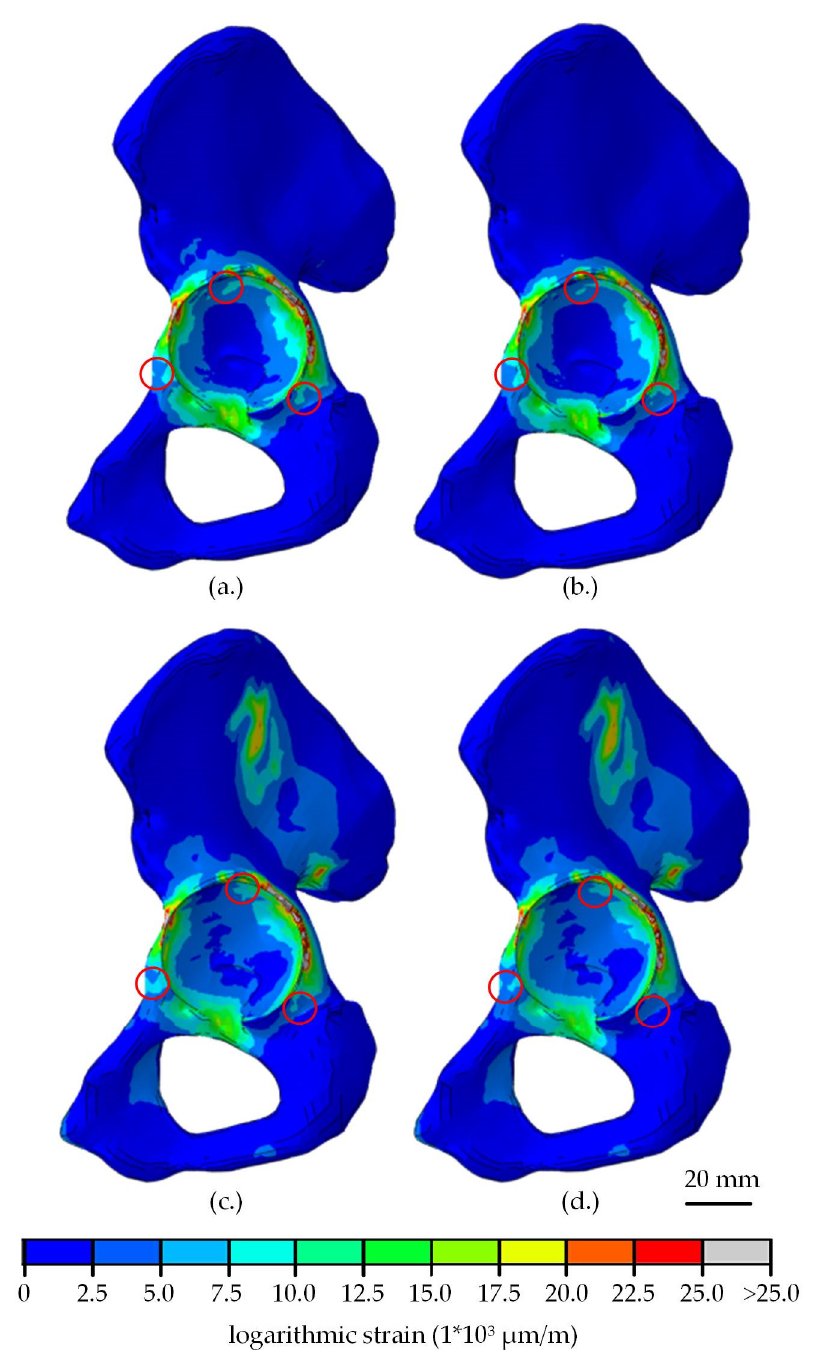
Figure 5. Comparison of strain distribution in the adjacent bone of the hemi-pelvis after the UHMWPE liner insertion into the titanium ( a ) and CFR-PEEK-15 ( b ) shell, followed by a relaxation. Additional the alteration of strain distribution after the application of a hip joint load in dependency of the shell material ( c : titanium, d :